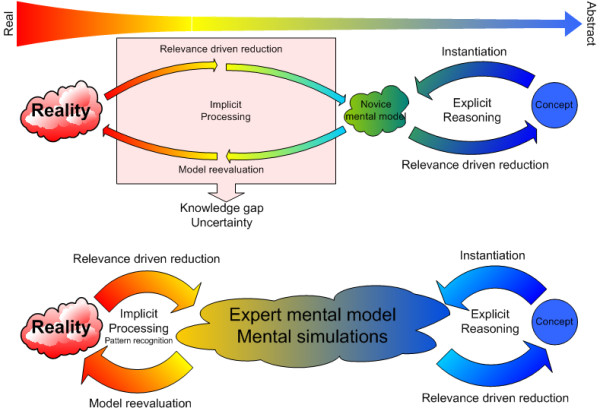
Knowledge representation and processing in novices and experts.